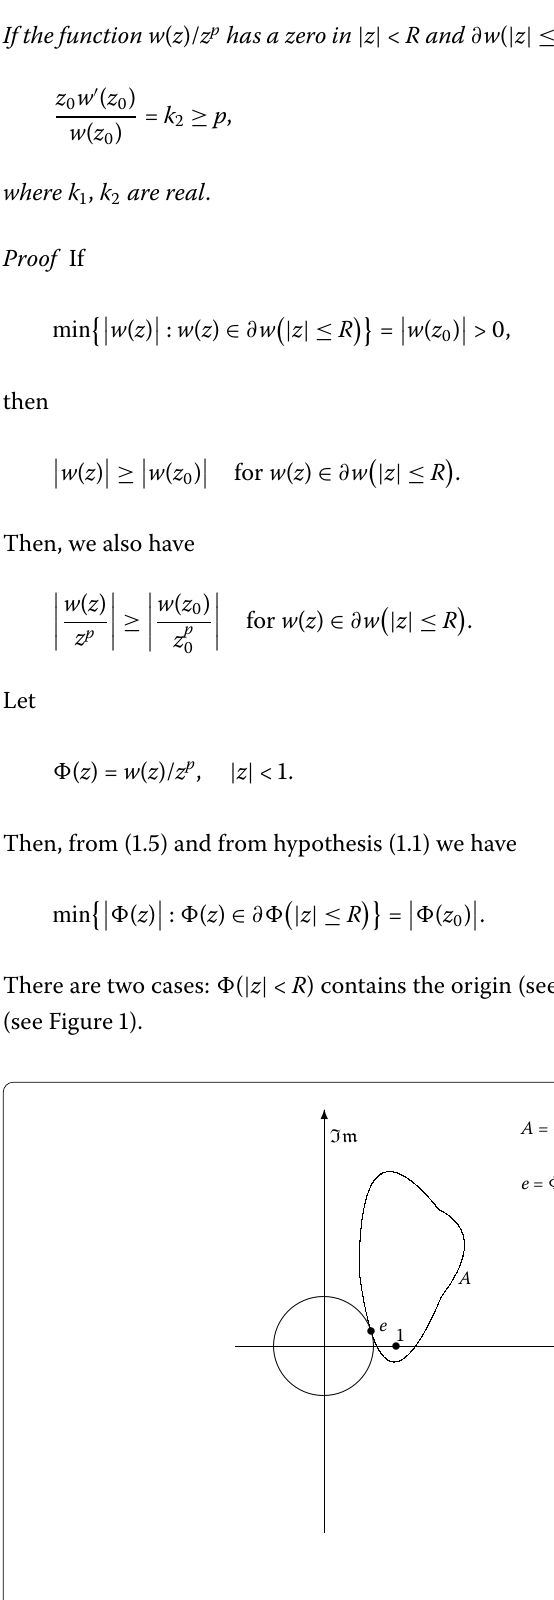
Figure 1 (cid:2) ( z ) in the case (cid:2) ( z ) (cid:2) =